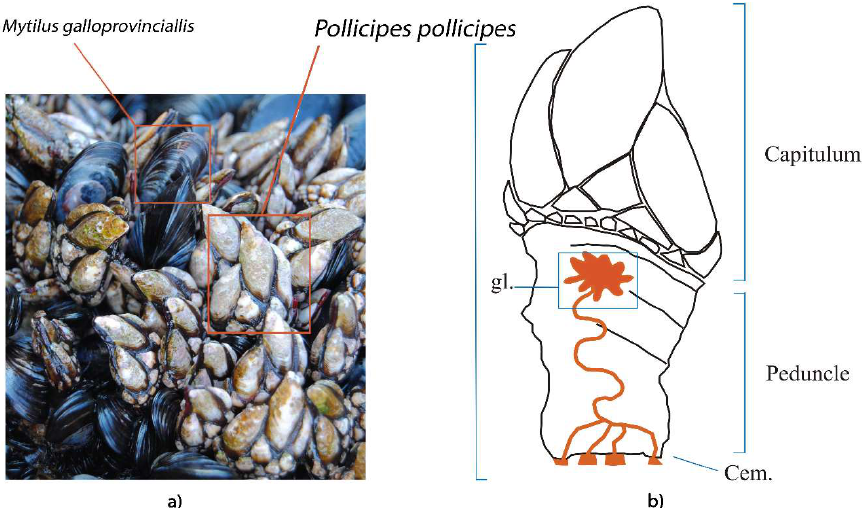
Figure 1. The goose barnacle Pollicipes pollicipes (Crustacea: Cirripedia) ( a ) attached to the rocky shore forming conspecific clusters alongside mussels; ( b ) schematic drawing showing sections of the peduncle, highlighting the cement apparatus, formed by clusters of adhesive-secreting cells that together constitute the gland (gl.), located in the upper central core embedded in an apical layer of connective tissue, just beneath the capitulum. Gland secretion passes through a network of ducts that carry the adhesive to the base of the peduncle forming the cement (Cem.). The original model of adult barnacle’s underwater adhesion [9] describes that the cement is secreted to the space between the animal cuticle and the external substrate, containing mainly two types of proteins, interfacial and bulk proteins. The formers are hydrophilic and located at the periphery of the cement complex, providing surface coupling with exterior surfaces through non-covalent interactions, and also interaction with interior hydrophobic bulk proteins. This model has been updated in the last years [10–12], including the notion that surface coupling relies on catechol groups, through various adhesive and cohesive forces, and that catechol, quinone, and lysine-based cross-linking are also involved in protein nanofibers’ curing and proper holdfast to the adhesion surface [10]. However, in barnacles, the catechol groups responsible for β -amyloid fibrils’ cross- linking of bulk proteins do not have a peptidyl origin, differently from other marine organisms, e.g., mussels and sandcastle worms; non-peptidyl catechol precursors and lysine are incorporated among bulk cement protein (CP52k and CP100k) fibrils through enzymatic reactions that involve peroxidases and lysyl oxidase [10], providing structure and mechanical characteristics to the composite. Six barnacle-specific cement proteins (CPs) have been identified, four of which are thought to be interface proteins, CP19k, −20 k, −43 k, and −68 k, and two bulk proteins, CP52k and CP100k, [13]. Barnacle-specific CPs are those proteins present in the cement that share no homology with any other marine adhesive proteins [13,14] or any other proteins at all.